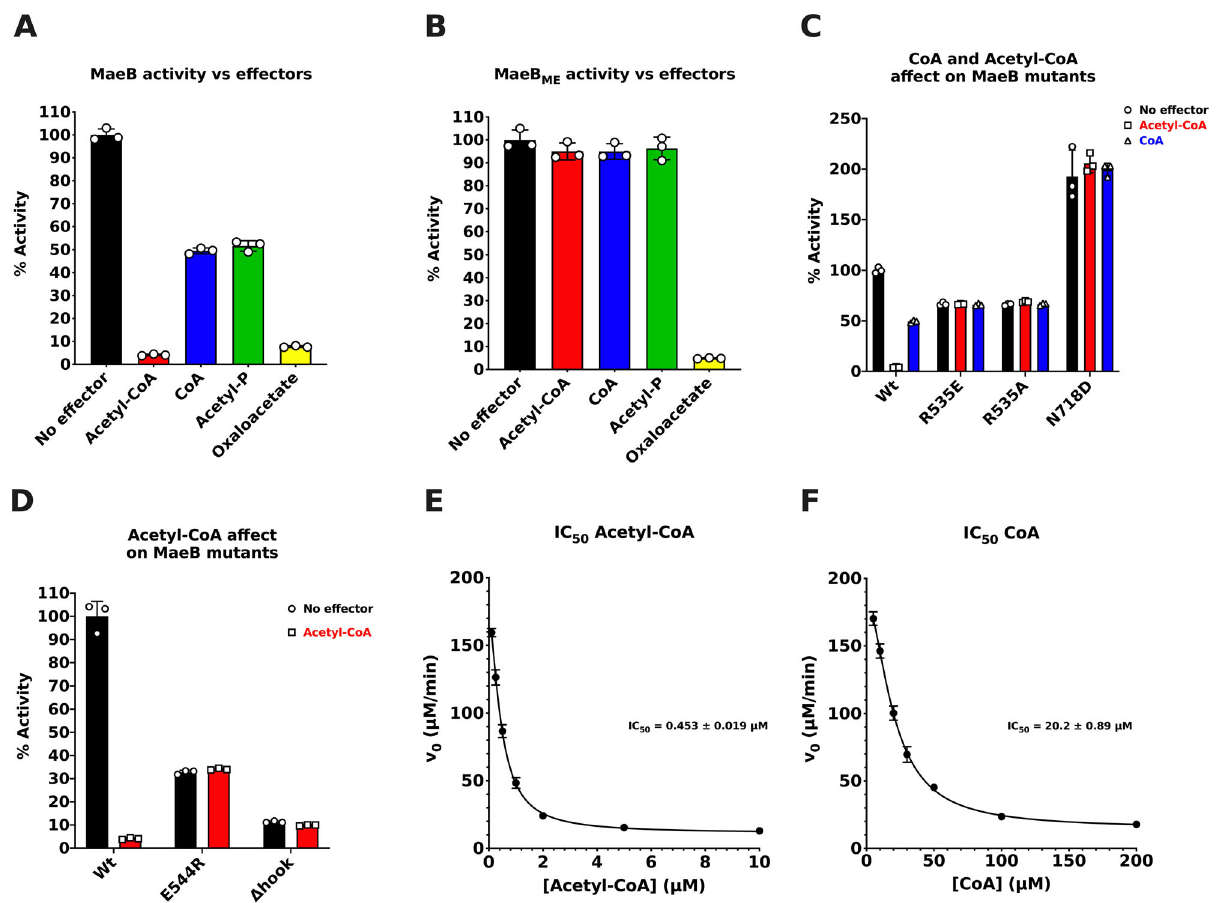
Fig. 2 Enzyme kinetics data of MaeB and variant proteins. A The % of MaeB activity in the presence of effectors in comparison to standard reaction conditions. MaeB is potently inhibited by oxaloacetate and acetyl-CoA. B The % of MaeB ME (ME domain only) activity in the presence of effectors in comparison to standard reaction conditions. MaeB ME is not inhibited by acetyl-CoA, CoA or acetyl phosphate, suggesting these molecules interact solely with the PTA domain. C The % activity of MaeB mutants, designed to distrupt the CoA binding pocket. R535A, R535E and N718D all became insensitive to inhibition by acetyl-CoA and CoA. R535 mutants have a reduced activity compared to wt, whereas the N718D mutant has an increased activity. D Comparison of the % activity of MaeB Δ hook and MaeB-E544R in the presence of acetyl-CoA. Datasets are normalised to the activity of MaeB under normal reaction conditions. See materials and methods for concentrations of effectors used. ( E + F ) IC 50 plot for acetyl-CoA and CoA, respectively. Acetyl- CoA IC 50 value is ~45 times smaller than that of CoA, suggesting MaeB is far more sensitive to changes in acetyl-CoA concentration. The data is plotted showing the mean value from triplicate experiments, with standard deviation error bars. Source data are provided in the Source Data fi